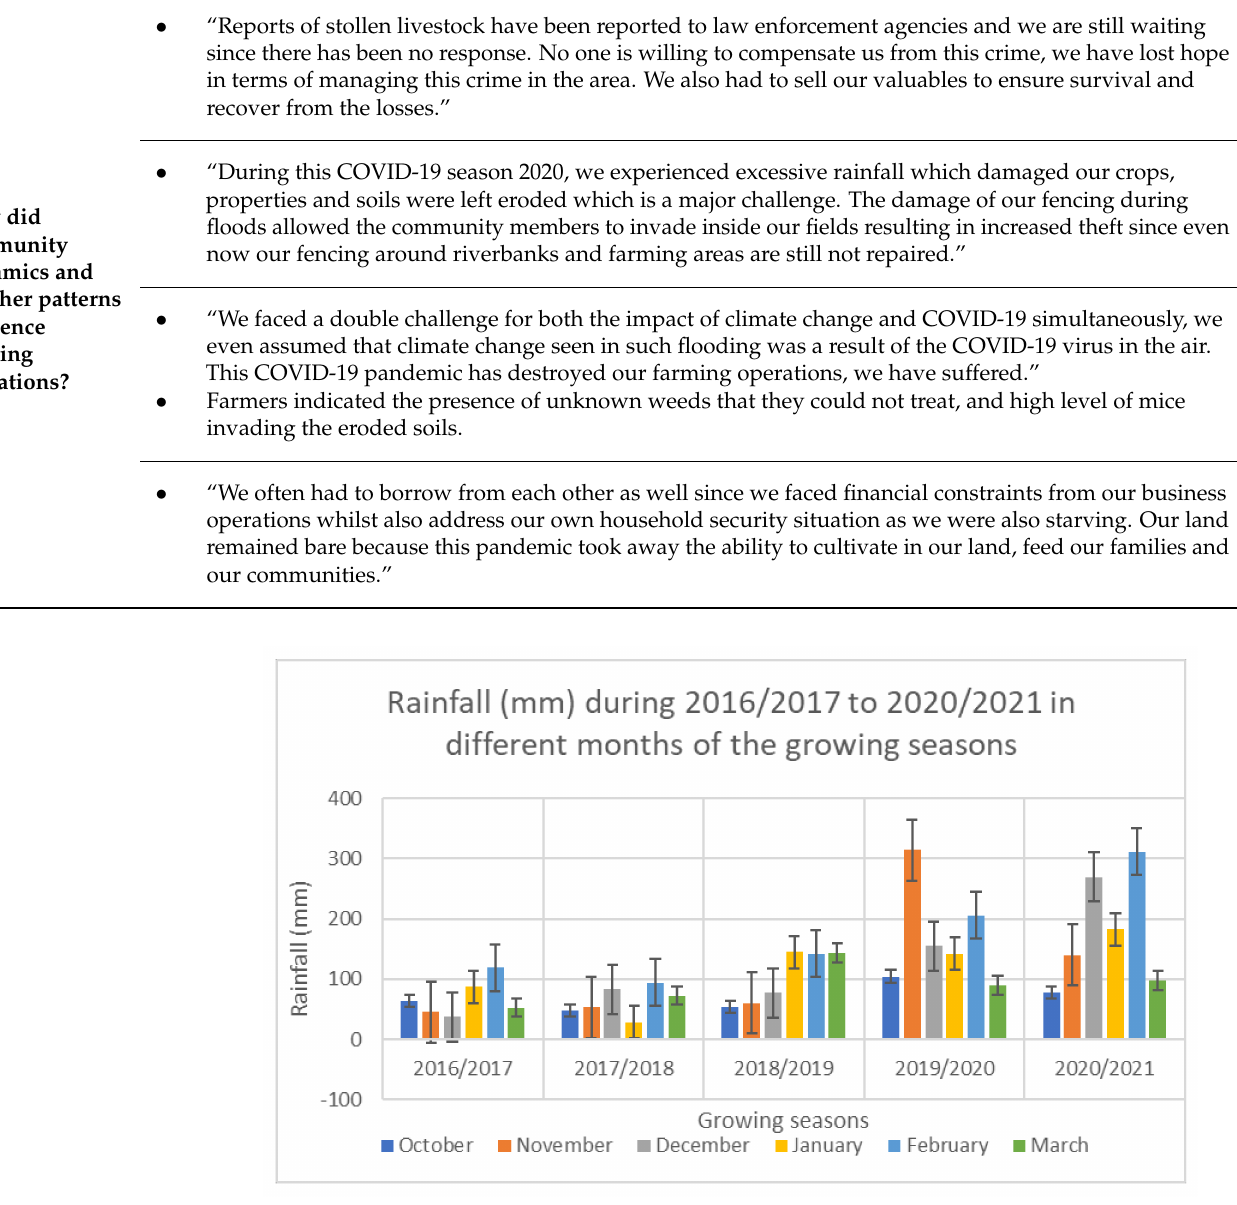
Figure 3. Rainfall (mm) patterns in different months during 2016/2017 to 2020/2021 of the growing seasons. Source: Weather and Climate